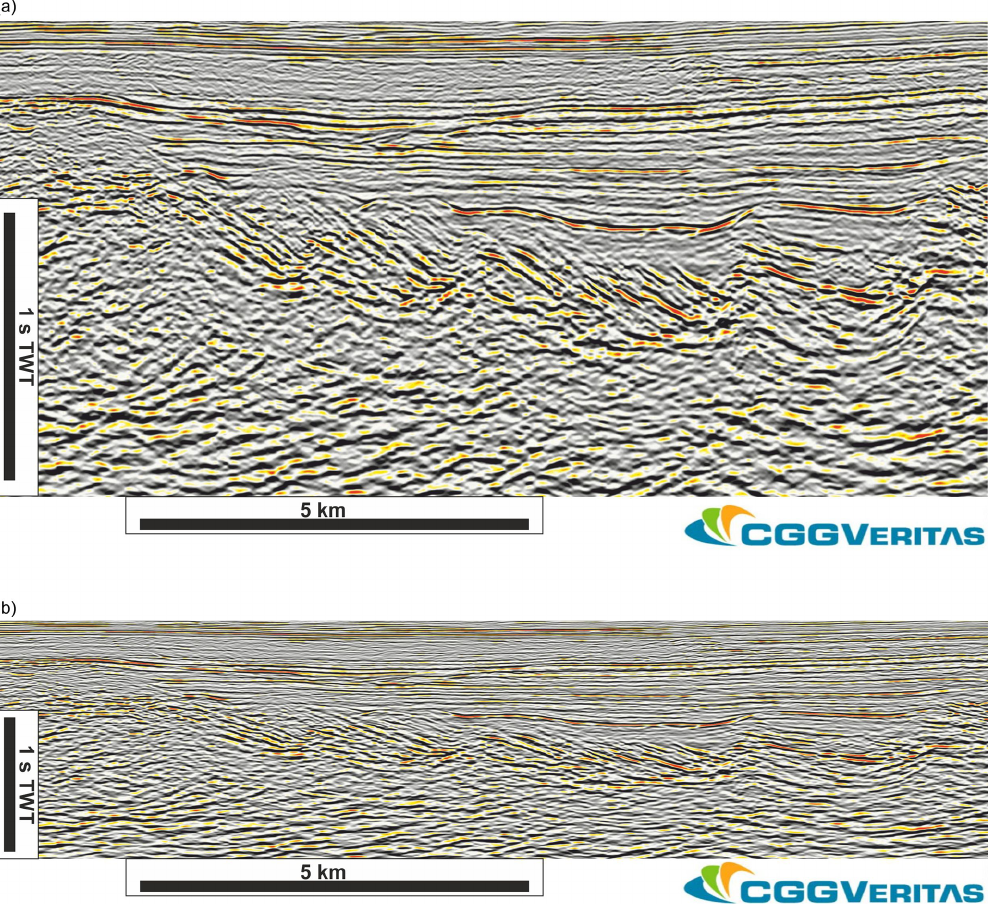
Figure 2. Seismic sections used in the interpretation experiment with (a) 1 : 4 vertical exaggeration and (b) 1 : 2 vertical exaggeration. These figures are portions of the full section in Fig. 1, and that can be downloaded from the VSA website (https://www.seismicatlas.org/entity?id= b39b298b-20fa-4944-a9b8-66b72d3a9ca8, last access: 30 September